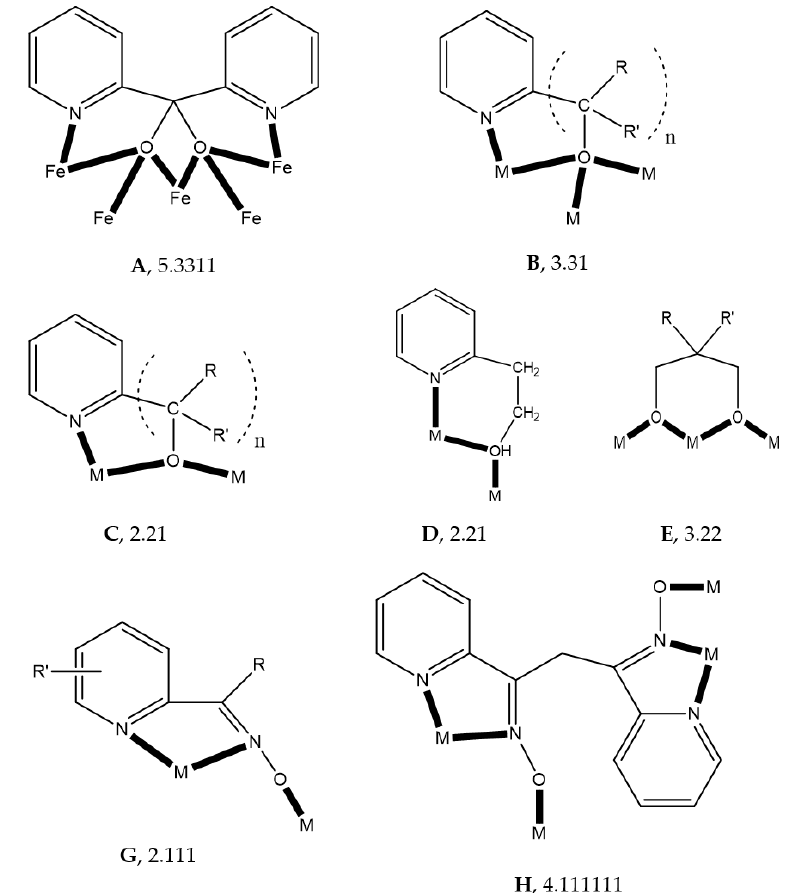
Figure 4. The coordination modes of some of the ligands discussed in the text and the Harris notation that describes these modes. M = metal ion (this is specified in the cited examples); n = 1, 2.